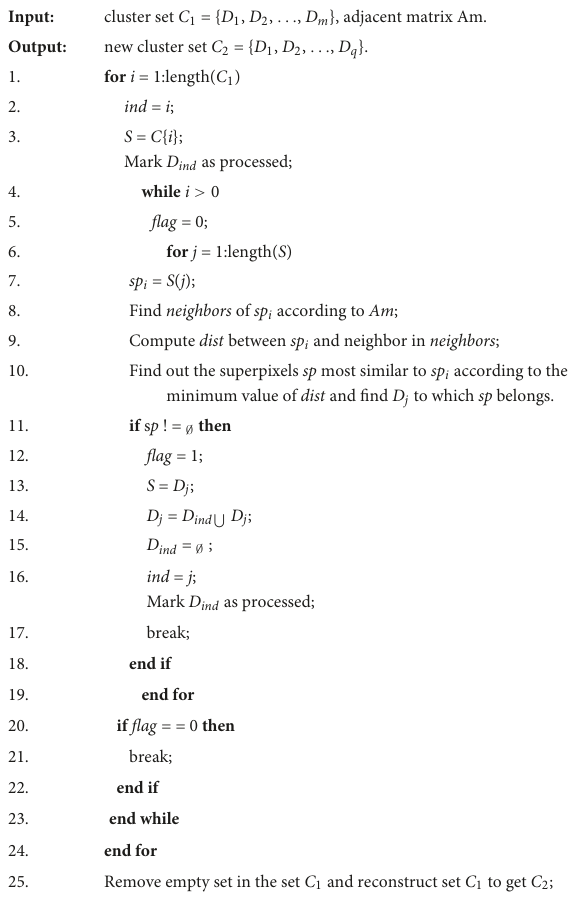
Algorithm 1 : Merging of clusters containing a specific number of superpixels